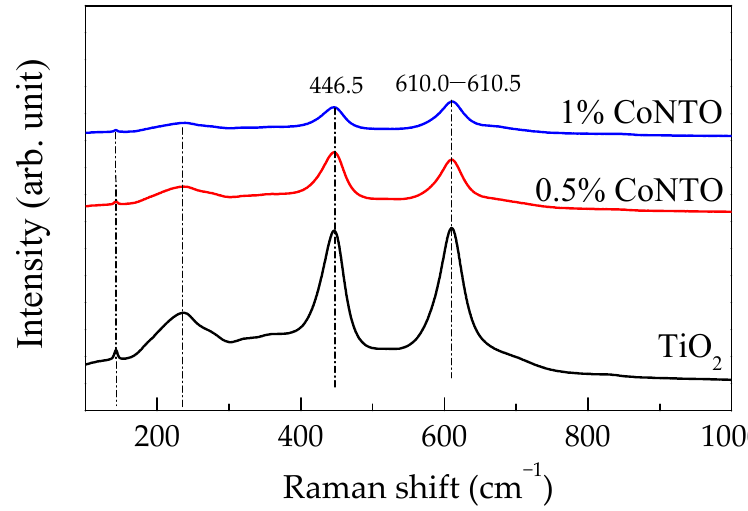
Figure 3. Raman spectra of TiO 2 , 0.5% CoNTO, and 1% CoNTO ceramics.